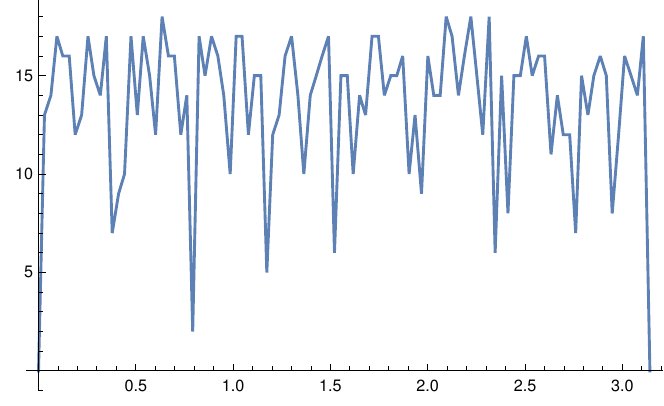
Figure 1 . Complexity as a function of (cid:18) for the state (2.3). The plot was done with k max = 19 and (cid:15) = 0 : 015. We see that complexity is a fairly discontinuous thing. It is apparent that this de(cid:12)nition depends on the choice of gates and it is not clear